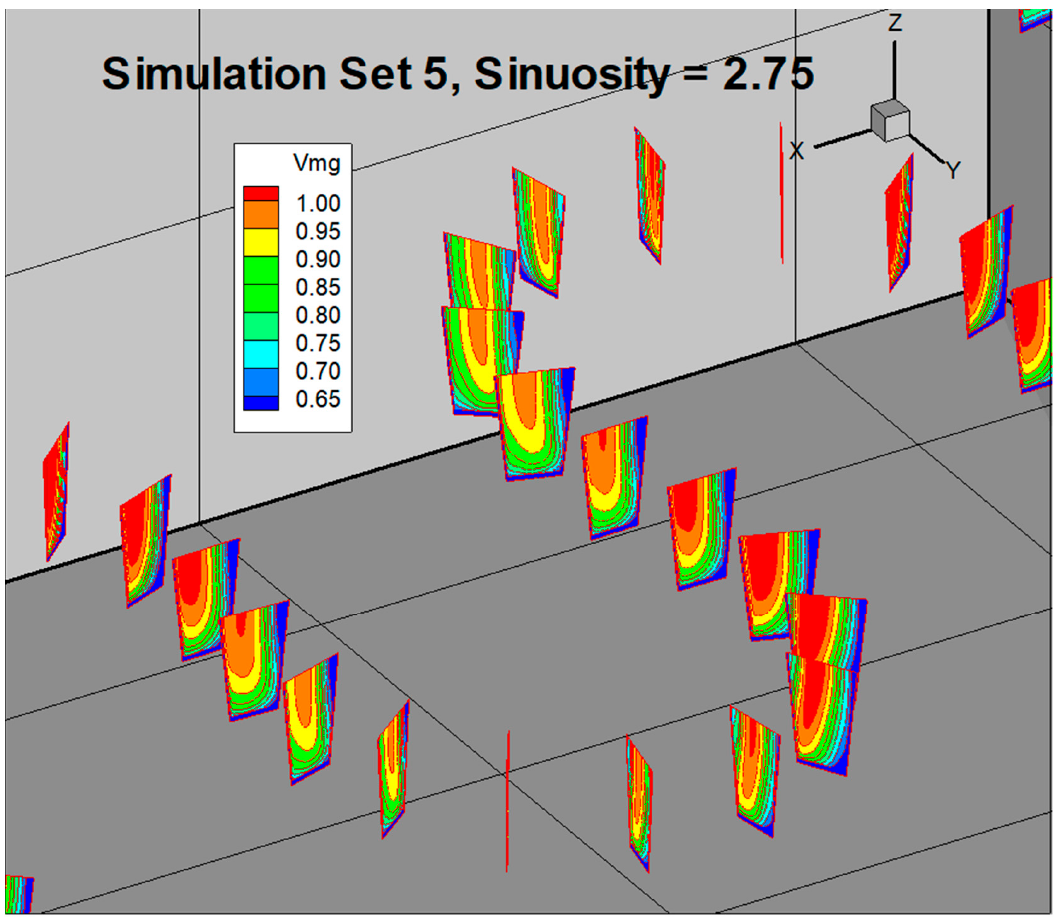
Figure 28. Close-up 3D view of cross-sectional slices of velocity contours.